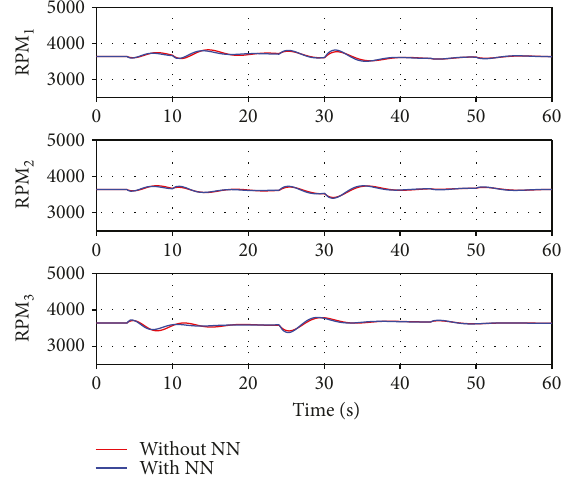
Figure 9: RPM control input in scenario 1.